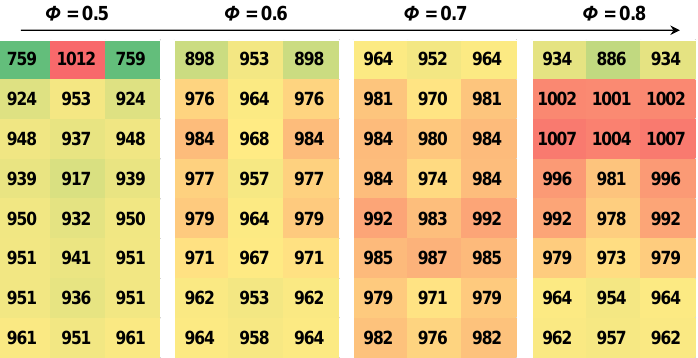
Figure 10. Temperature distributions for various overall equivalence ratios at p = 150 kPa and S = 4.56.